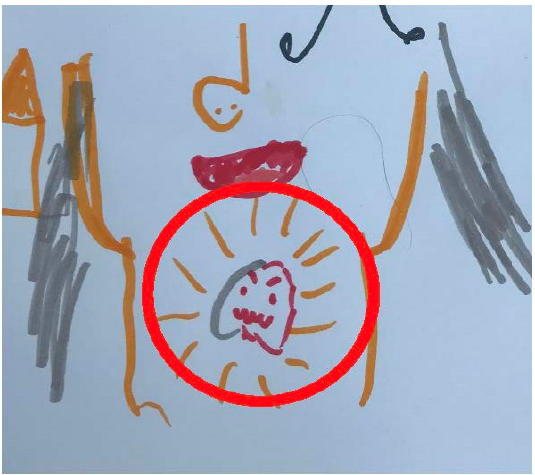
Figure 5. Child’s drawing of parent’s cancer site (James; male: 6 years) .